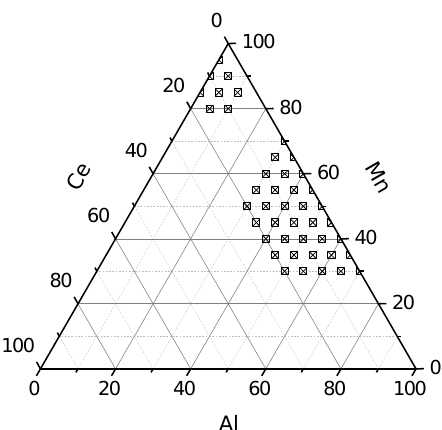
Figure 6. Sample compositions in areas of potential hits after results of ecIRT measurement of slate library plate 1. Axis labels denoting the mole fraction χ of given element as percentage, PMs are excluded from calculation. Compositions: Pt 3 Al a Mn b Ce c , Pt 1.5 Rh 1.5 Al a Mn b Ce c . ∆ T [ K ] 3